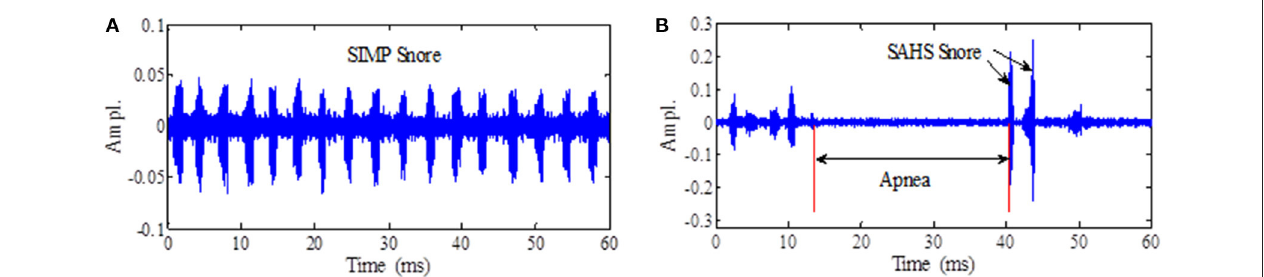
FIGURE 2 | (A) The simple snore wave. (B) The SAHS snore wave.